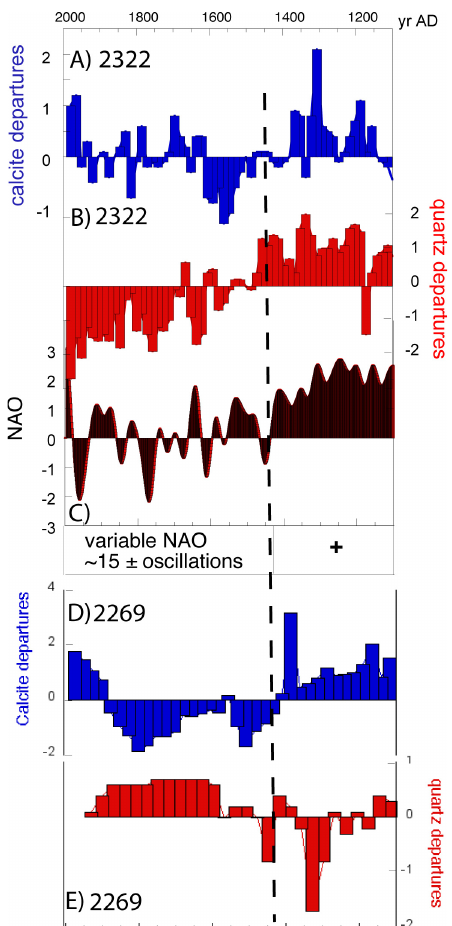
Fig. 12. Departures from the mean for the last 900yr for calcite ( A and D ) and quartz ( A and D ) and quartz ( B and E ) at sites MD99- 2322 and MD99-2269 (Fig. 1) against the NAO index (C) (Trouet et al., 2009; Kinnaid et al., 2011). The vertical dashed line ∼ 1450AD represents the time of a major